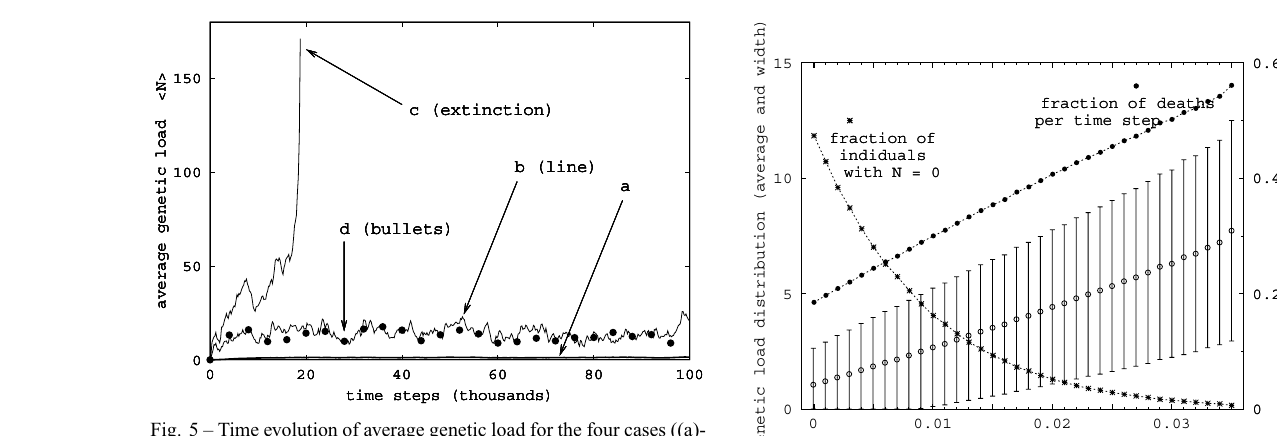
Fig. 5 – Time evolution of average genetic load for the four cases ((a)- (d)) described in the text. Case (c) leads to extinction, while case (d) shows survival when selection is increased.